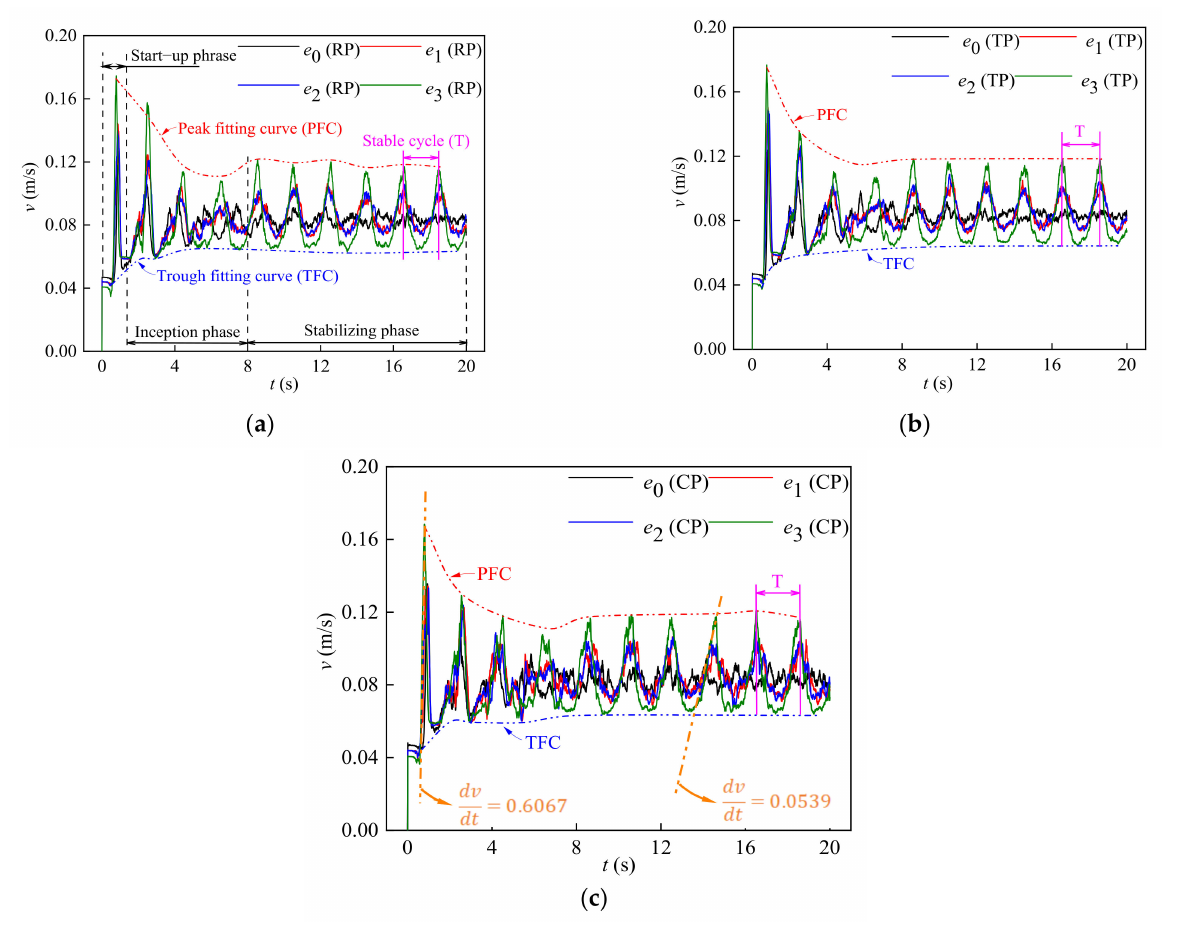
Figure 5. The average velocity of flake particles under different eccentricities at 15 rpm. ( a ) Rectangu- lar flake particles; ( b ) triangular flake particles; ( c ) circular flake